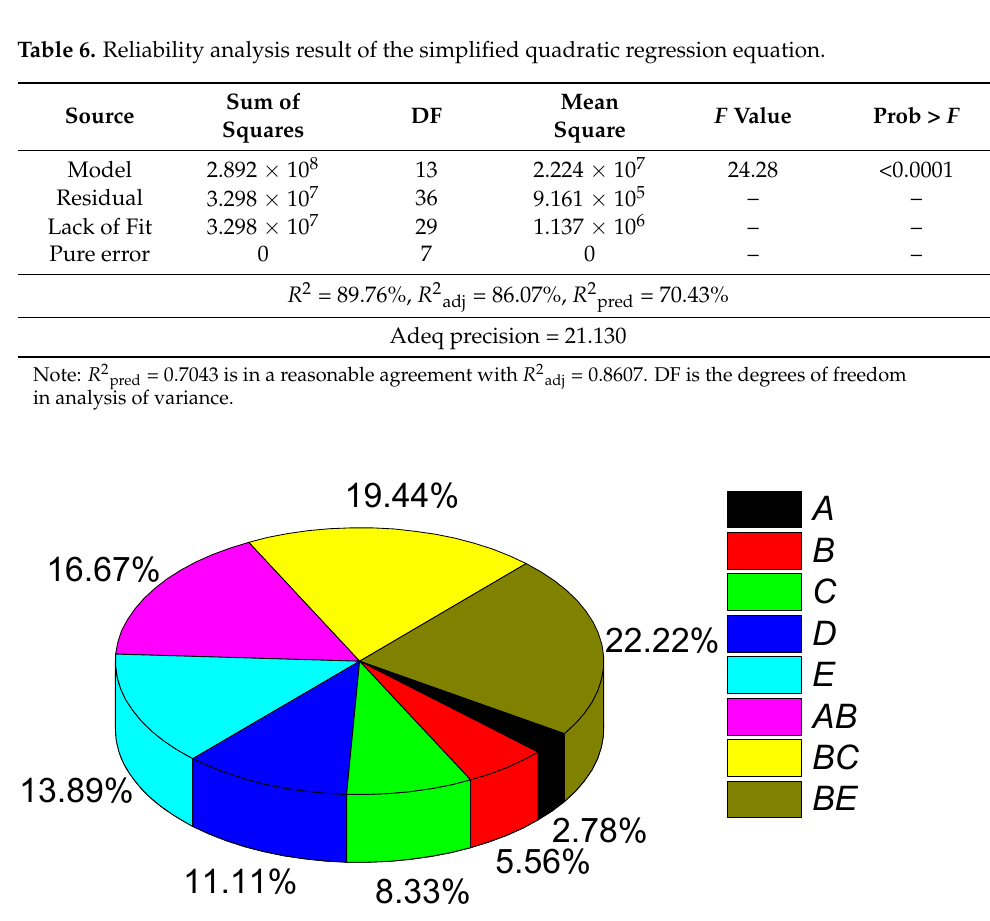
corrosion resistance of the coating. To facilitate the analysis of the influences of each research variable and their inter-